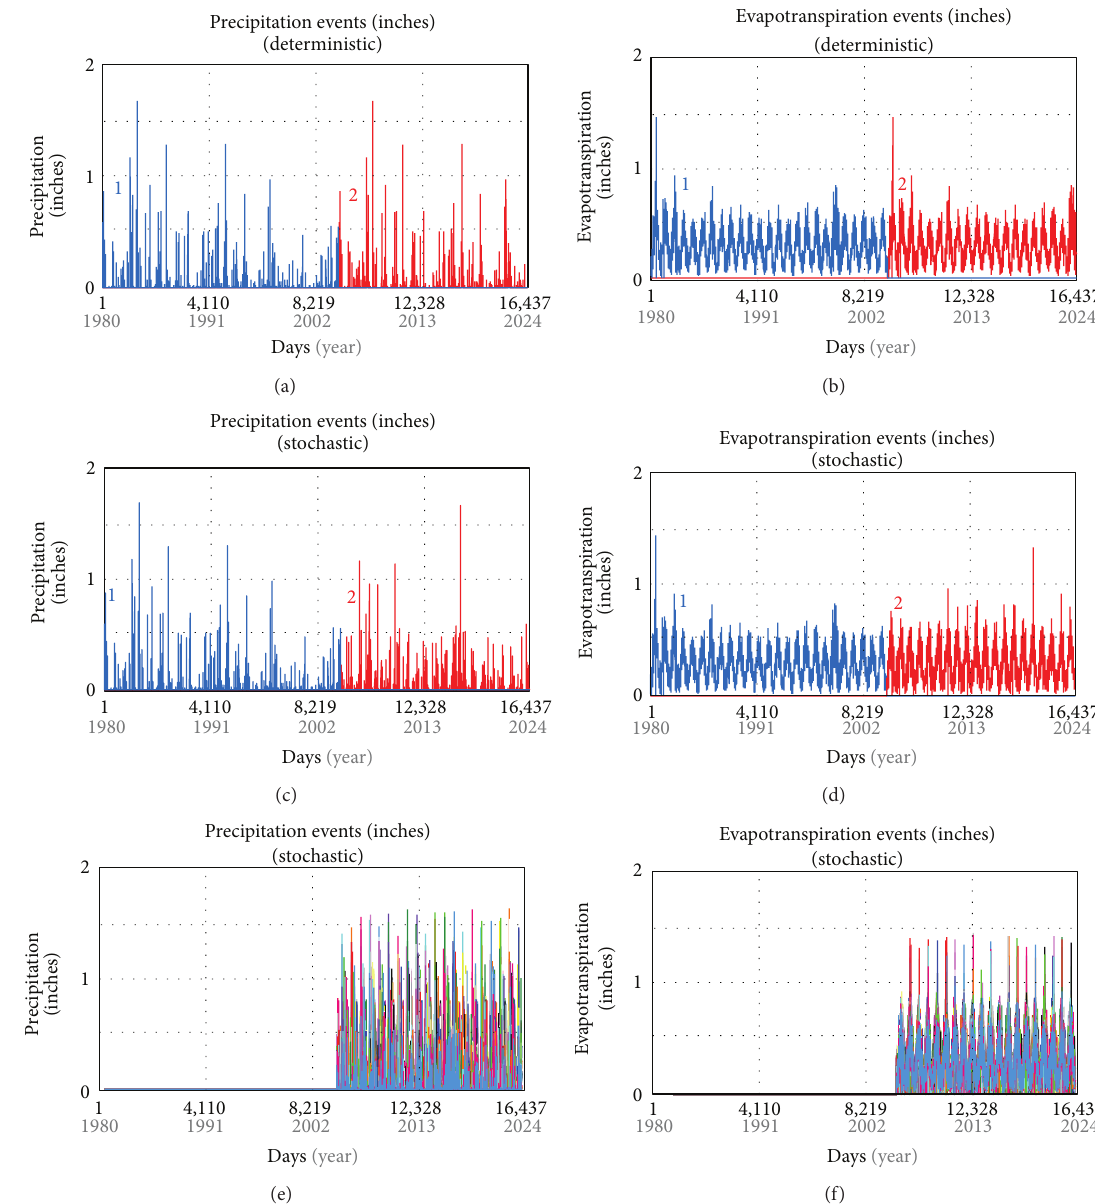
Figure 4: Comparison of historic (1) versus simulated (2) and deterministic versus stochastic climates for the S 4 M daily time step: (a) precipitation (Prcp) events (inches)—simulated deterministic, (b) evapotranspiration (ETo) events (inches)—simulated deterministic, (c) Prcp events (inches)—simulated stochastic, (d) ETo events (inches)—simulated stochastic, (e) Prcp events (inches)—simulated stochastic (100 repetitions), and (f) ETo events (inches)—simulated stochastic (100